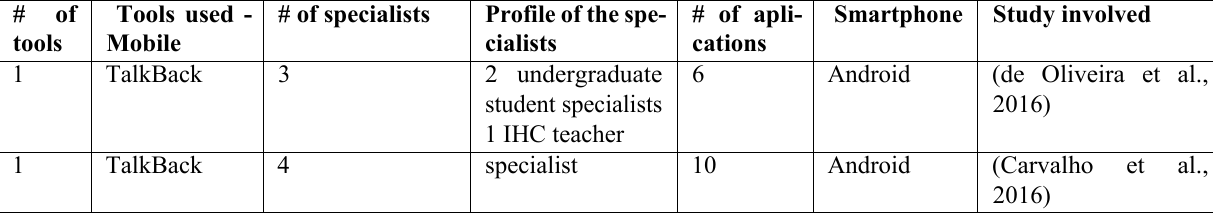
Table 5. Characteristics of accessibility inspections by specialists on mobile